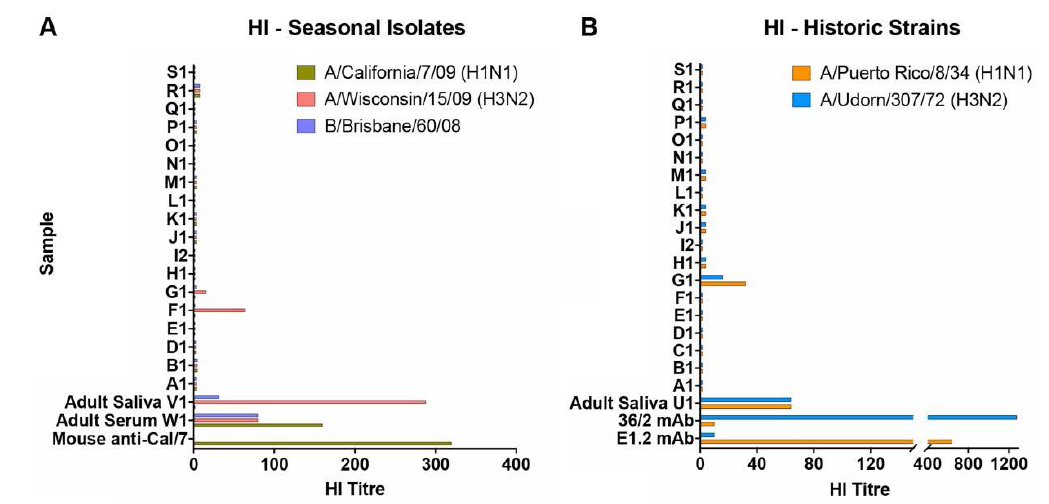
Figure 1. Hemagglutination inhibition activity of human infant saliva. The ability of saliva samples to inhibit virus-induced hemagglutination of chicken erythrocytes was assessed against ( A ) A/California/7/09 (H1N1), A/Wisconsin/15/09 (H3N2), and B/Brisbane/60/08 viruses and ( B ) PR8 (H1N1) and Udorn (H3N2). Adult serum and saliva samples, mouse antiserum raised against inactivated purified A/California/7/09 (a gift from CSL Ltd.), and HA-specific monoclonal antibodies against PR8 (E1.2) or Udorn (36/2) were included as controls. Data represent the mean of at least duplicate samples.